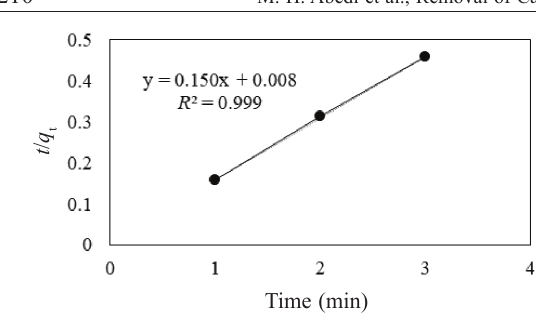
Fig. 10 – Plotting the pseudo-second-order kinetic model in optimum